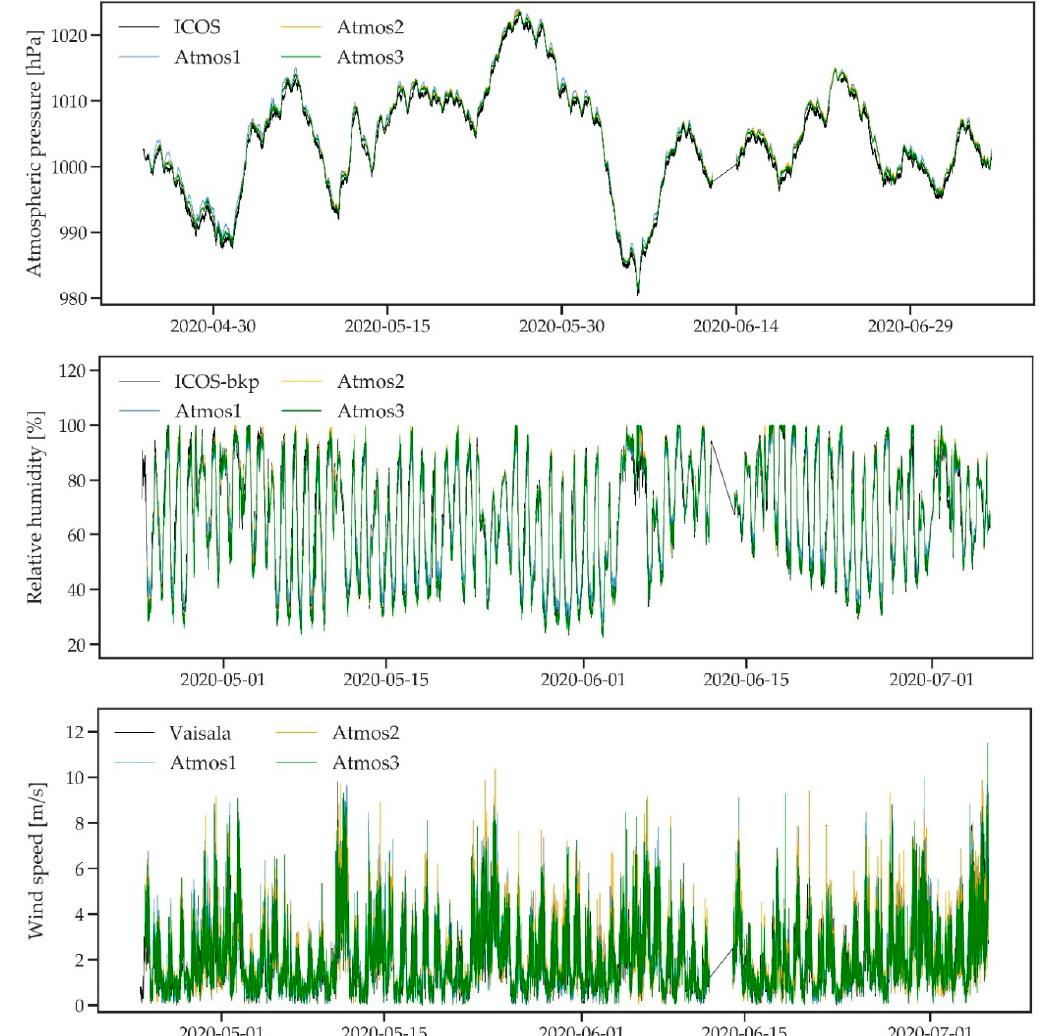
Figure A1. Full time series for all standard weather variables measured by three ATMOS41 weather stations and the reference ICOS-bkp, ICOS or Vaisala weather station.